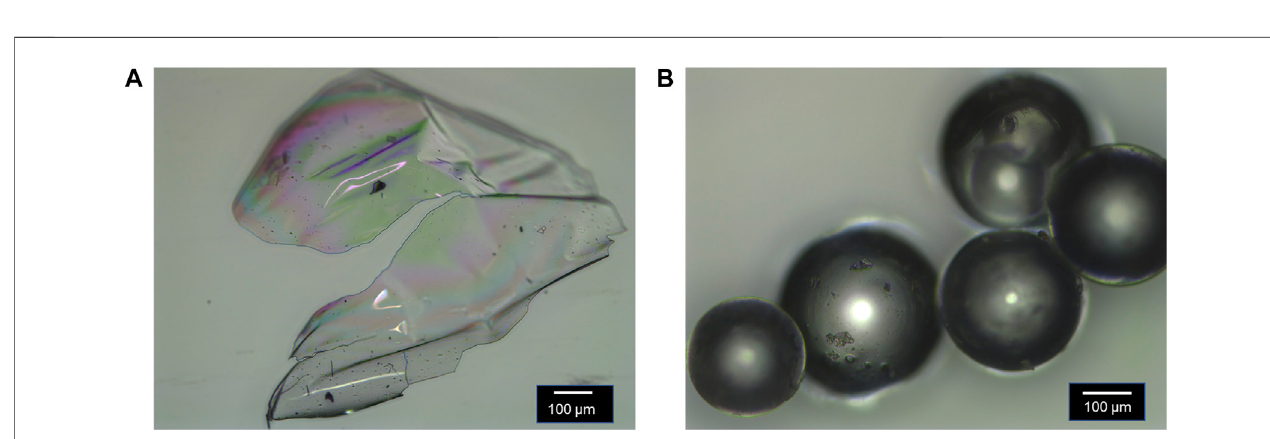
FIGURE 2 | Synthetic outline for (A) linear and (B) crosslinked pyridine-functionalized polymers.